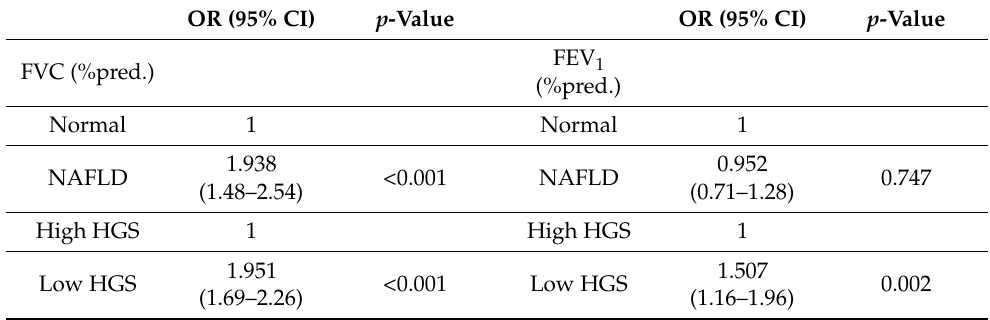
Table 3. The risk of reduced pulmonary function according to NAFLD and relative HGS.